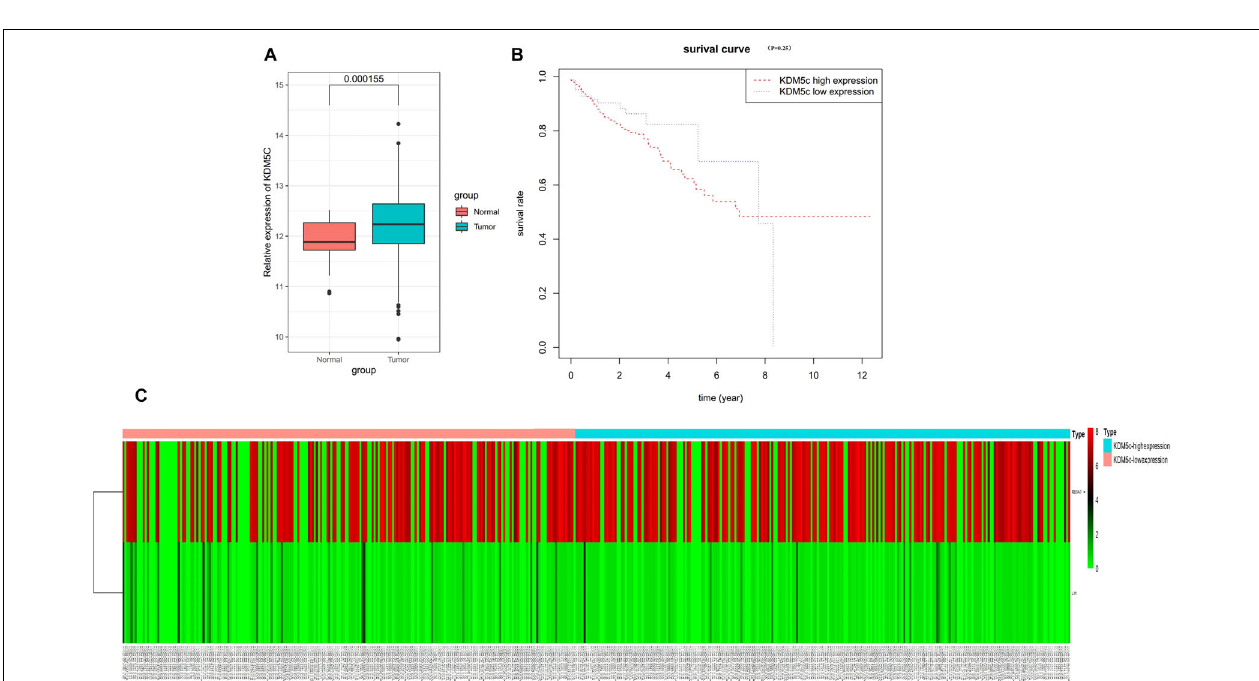
FIGURE 7 | TCGA database analysis. (A) TCGA dataset analysis revealed that the KDM5c mRNA levels were significantly increased in colon cancer, ( P < 0.05). (B) Overall survival rates of patients with colon cancer stratified by the expression of KDM5c were analyzed via Kaplan-Meier survival analysis. (C) Heat map of the methylation levels of the FBXW7 and JUN genes in 473 human colon cancer tissues as sourced from TCGA. The upper panel shows that colon cancer tissues with higher KDM5c expression exhibit higher methylation levels in the FBXW7 gene. The lower panel shows that KDM5c expression in colon cancer tissue has no relationship with the methylation level in the c-Jun